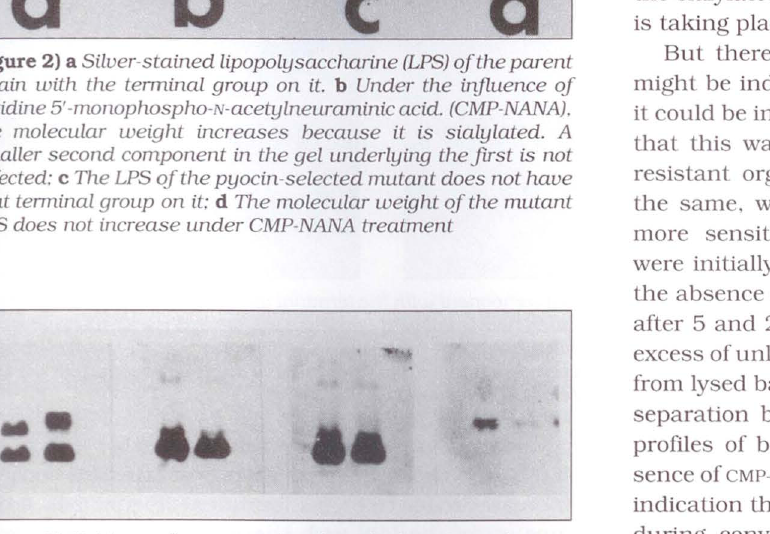
Figure 3) Evidence from monoclonal antibodies. In each case. the tracks on the right show the effect of treatment with cytidine 5'-monoplwspho-N-acetylneuraminic acid (CMP-NANA). Far left The silver-stained lipopolysaccharine (LPS) gel of a revertant of the previous mutant which made both types of LPS. Centre two panels Blotting with two monoclonal antibodies (MAbs) that recognize epitopes on the main structure. not the tenninal group (their reactions are not influenced by incubation with CMP NANA). Right panel Blotting with the MAb that detects the terminal group before treatment with CMP-NANA but not